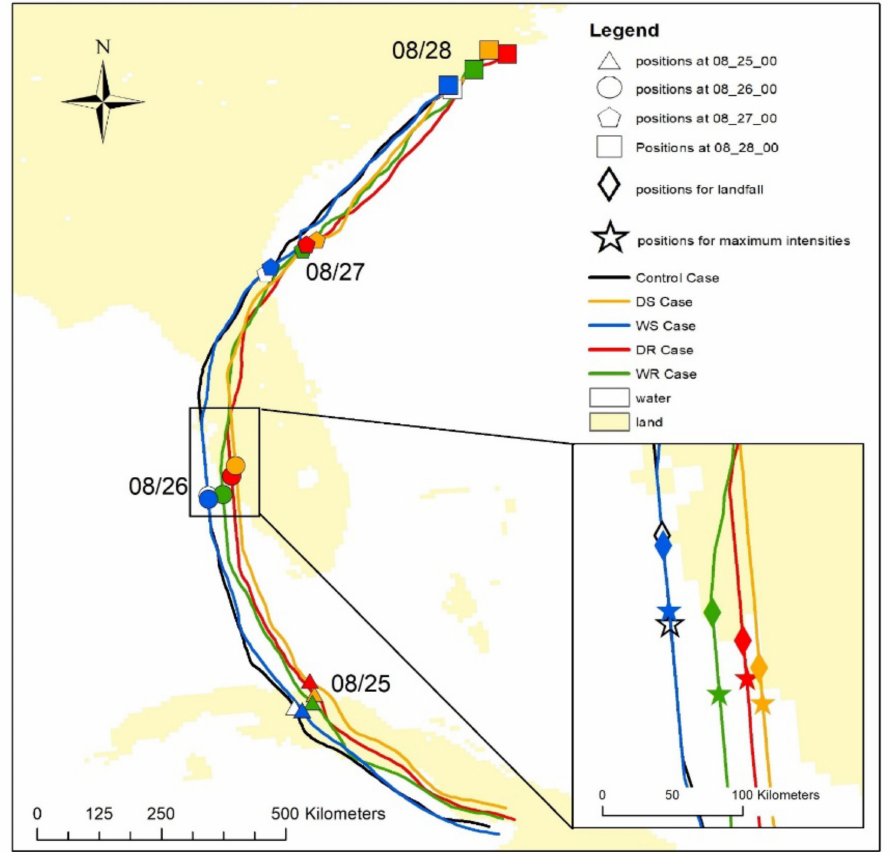
Figure 2. All storm tracks after leaving Cuba and location of maximum intensity, first U.S. landfall and positions each 0000 UTC from 25 August to 0000 UTC 28